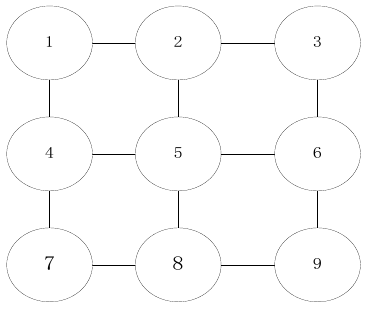
Figure 2. The structure of the multi-convolution neural network.